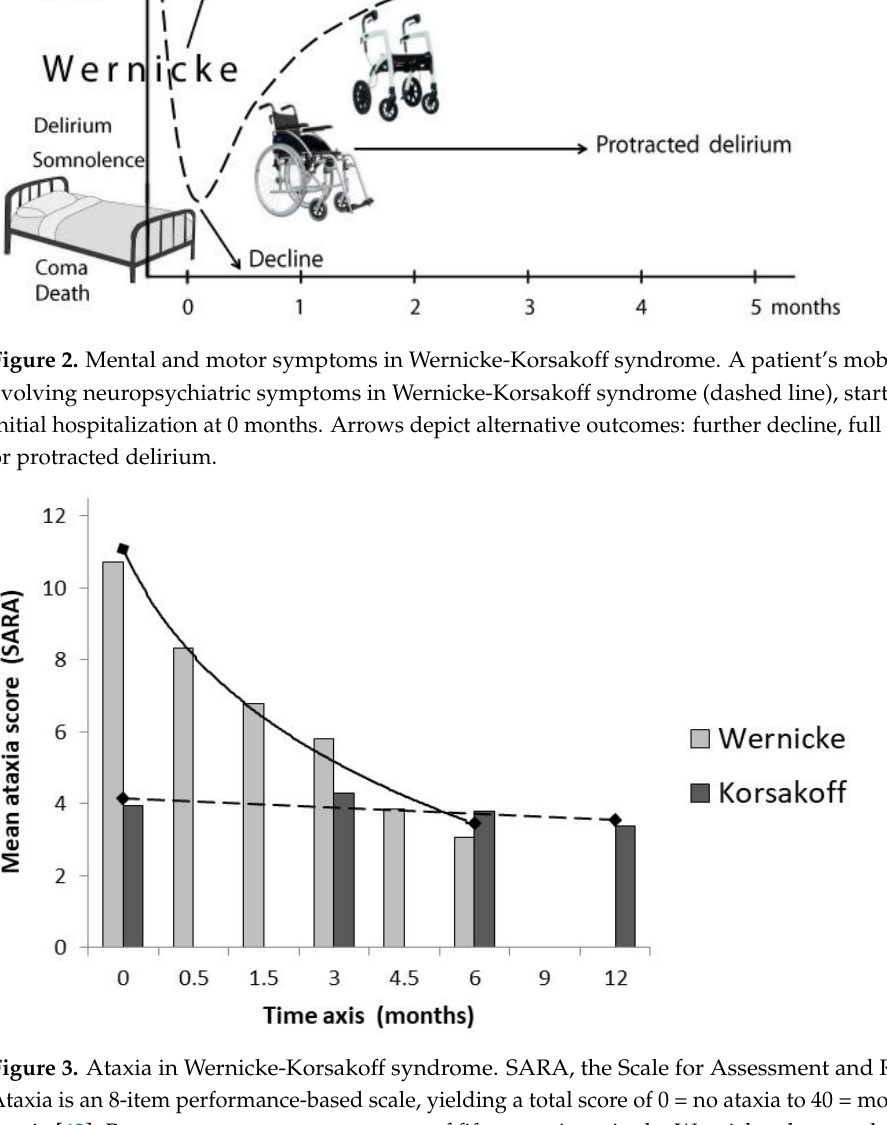
Figure 3. Ataxia in Wernicke-Korsakoff syndrome. SARA, the Scale for Assessment and Rating of Ataxia is an 8-item performance-based scale, yielding a total score of 0 = no ataxia to 40 = most severe ataxia [63]. Bars represent mean sum scores of fifteen patients in the Wernicke phase and ten other patients in the chronic Korsakoff phase. The time axis shows the follow-up of SARA scores in both patient groups and starts, respectively on the date of admission in the Wernicke group and on the date of the first measurements in Korsakoff patients, who have been admitted for 18 months or more, in Slingedael Korsakoff center, Rotterdam.